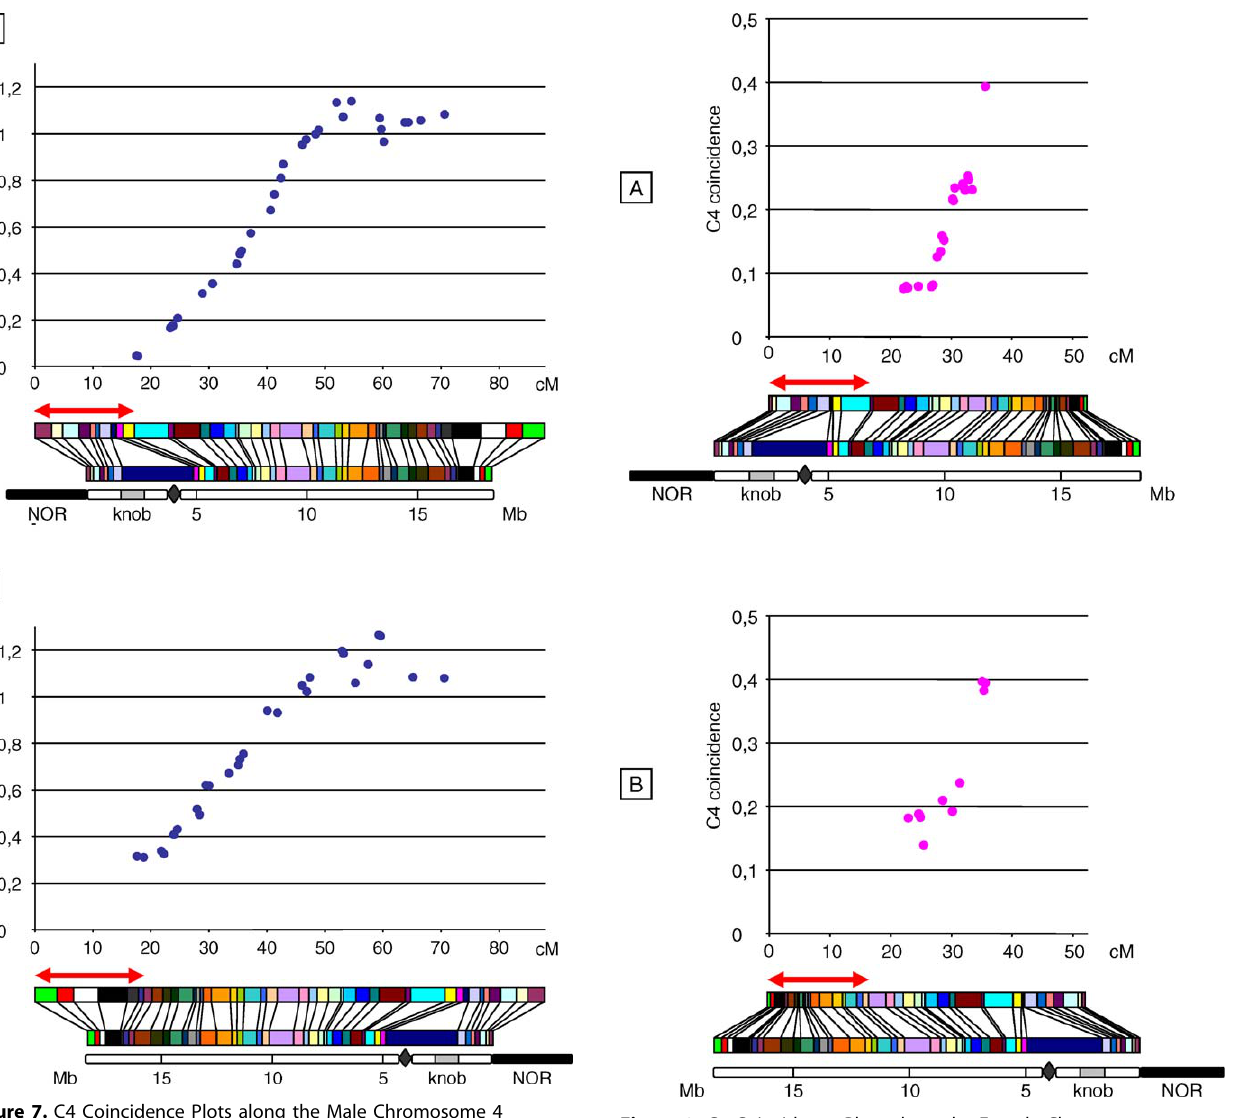
Figure 8. C4 Coincidence Plots along the Female Chromosome 4 All possible combinations between a fixed and a nonoverlapping interval (each being 17.5 cM 6 5%) were used for calculation of coefficient of coincidence, defined as the frequency of double-COs divided by the frequencies of COs in both intervals (see Materials and Methods). These C4 coincidence values were plotted against the genetic distance between the centers of the intervals. The fixed interval is located at the end of either (A) the short arm or (B) the long arm. Each plot is aligned with the corresponding genetic map, the physical map, and a schematic representation of the chromosome, which includes 5-Mb scale coordinates, centromere (diamond), heterochromatic knob (gray box), nucleolar organizer region (NOR, black box). For both plots, abscissa values indicate the genetic distance between the centers of the fixed and the ‘‘ moving ’’ interval. The red two-headed arrow indicates the fixed interval position.